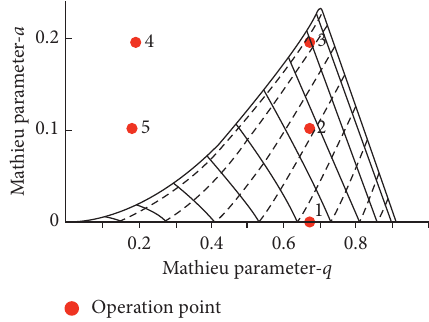
Figure 13: Location of operation points relative to a stable Table 2: Experimental results obtained at 20Pa.